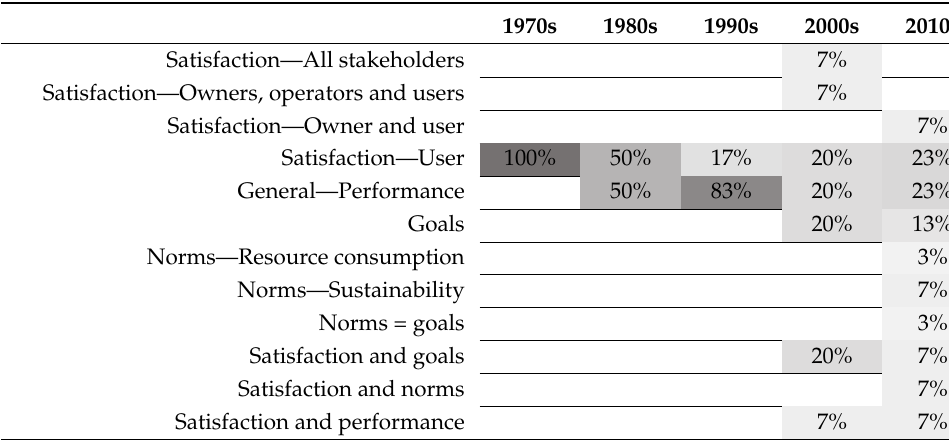
Table 2. The proportion of the models’ adoption in five decades of the concept development (accord- ing to the model adopted by collected